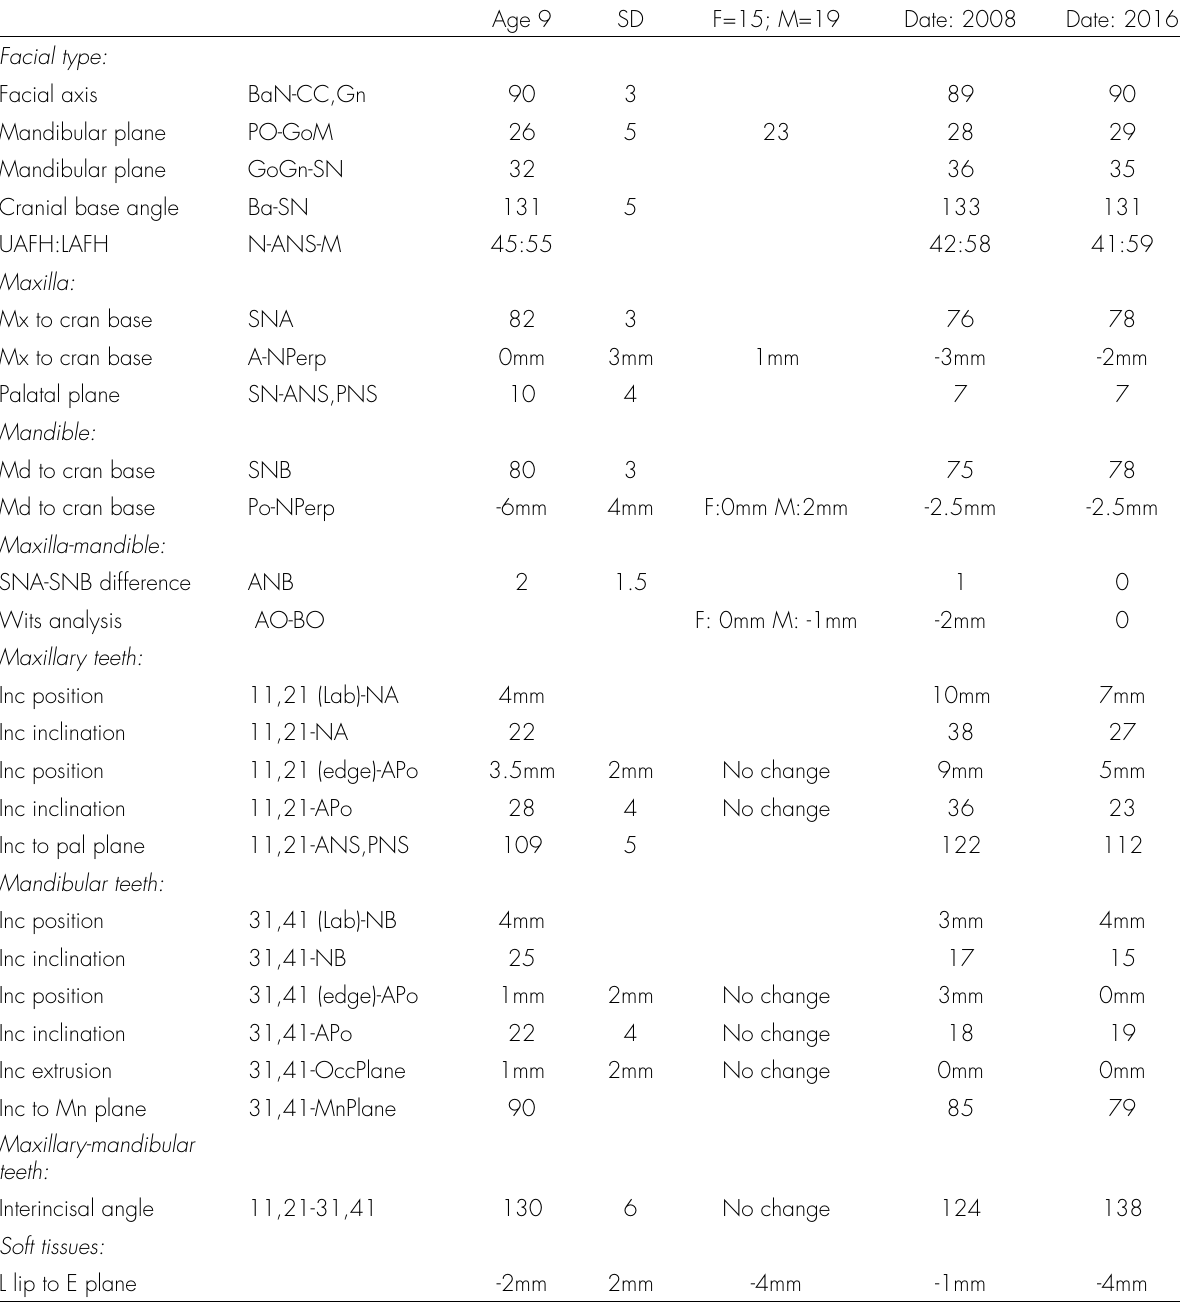
Table I. Cephalometric